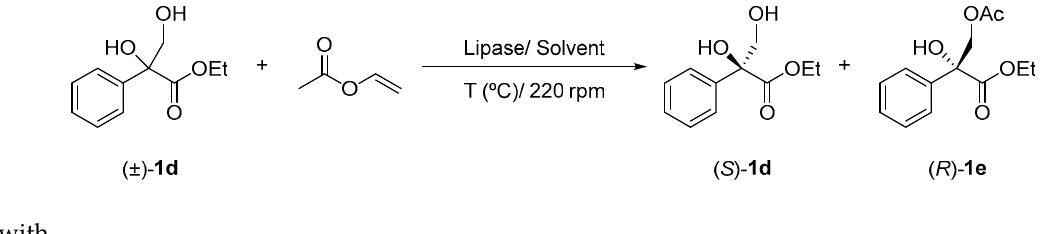
Table 3. PSL-C catalysed kinetic resolution of racemic diols 2 – 6d in tert -butyl methyl ether (TBME) at 30 °C using vinyl acetate as the acyl donor.